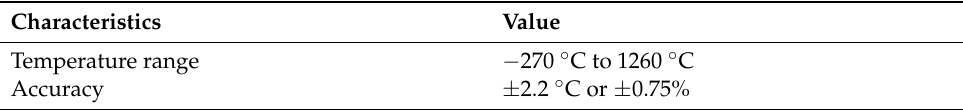
Table 5. Specifications of the Type K